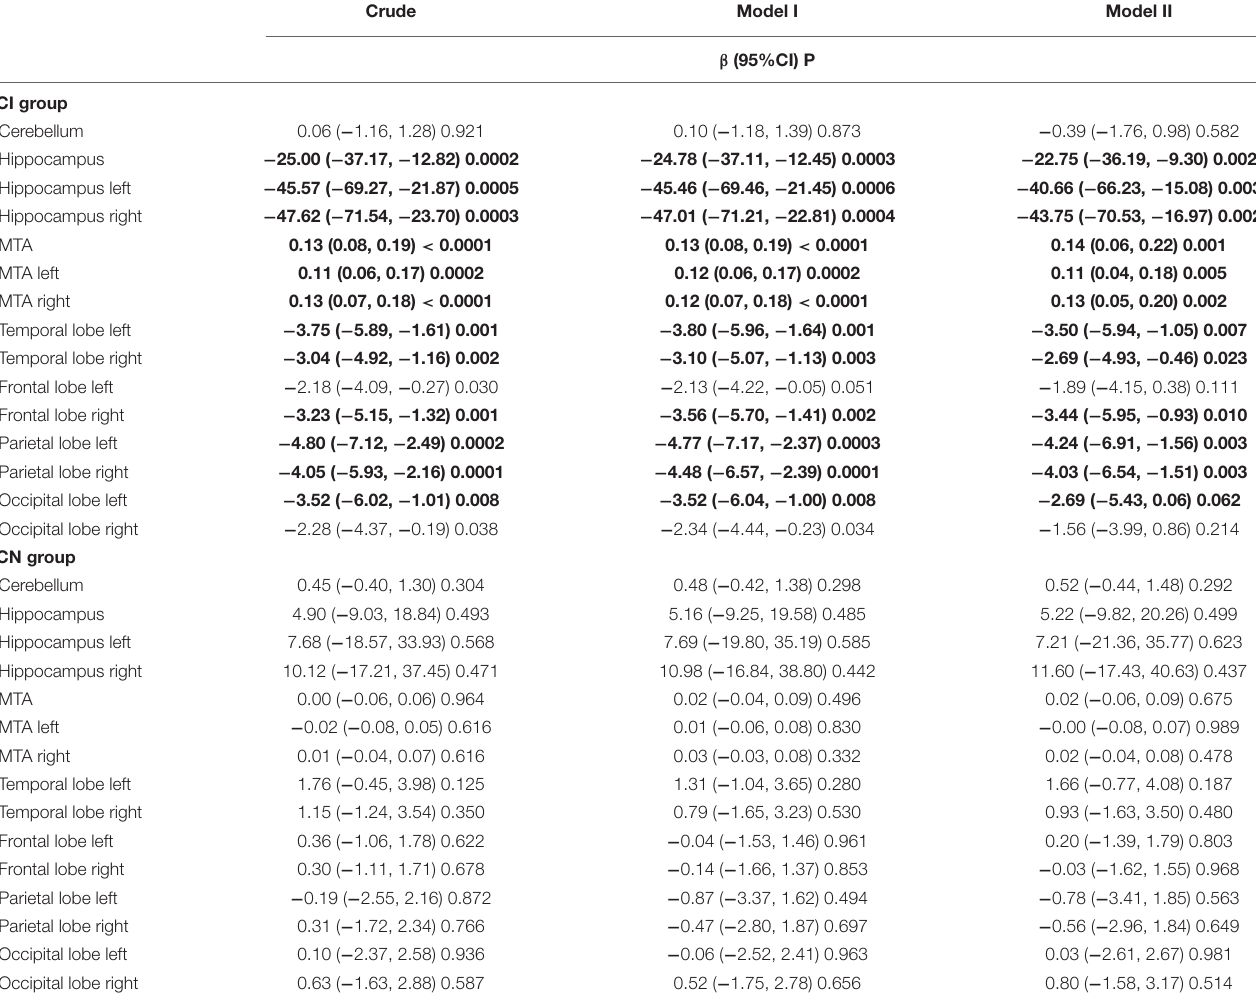
TABLE 4 | Association between brain volumes and timed up and go (TUG) time in different groups